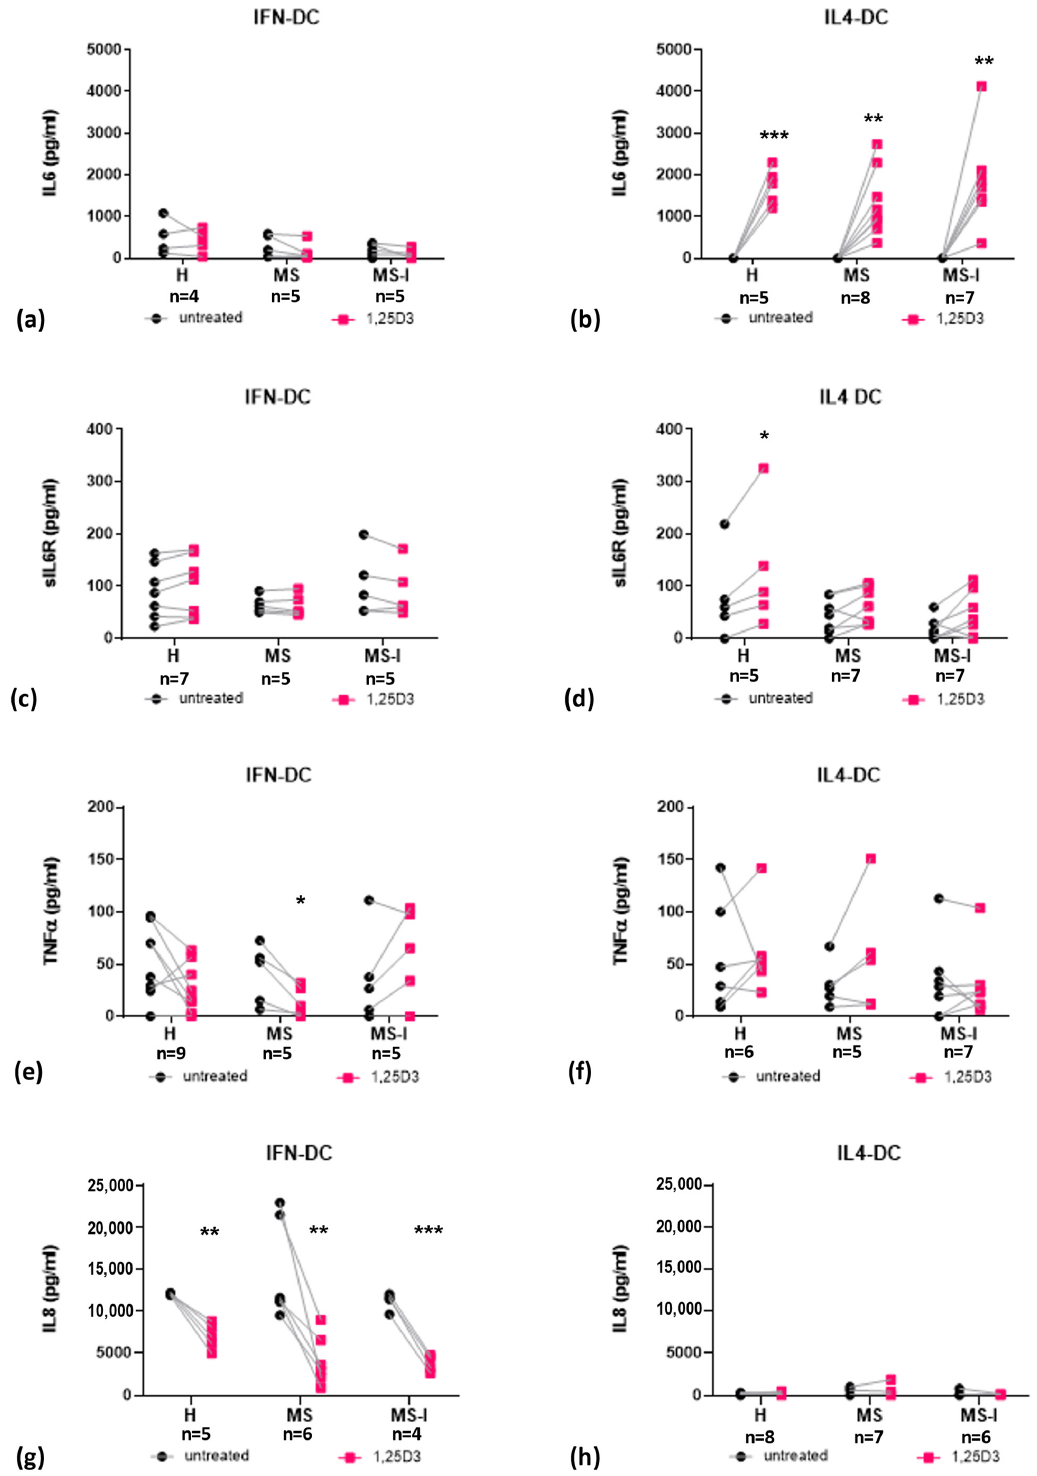
Figure 3. Expression and modulation by 1,25(OH) 2 D3 of pro-inflammatory cytokines. IL6 ( a , b ), sIL6R ( c , d ), TNF α ( e , f ) and IL8 ( g , h ) concentrations measured in IFN-DC ( a , c , e , g ) and IL4-DC ( b , d , f , h ) supernatants from H, MS, and MS-I donors are shown as individual values. Number of subjects (n) analyzed are indicated. Black dots represent untreated cells, pink squares represent 1,25(OH) 2 D3 treated cells. 1,25(OH) 2 D3 treatment effects were tested by Student’s t -test for paired samples. * p ≤ 0.05, ** p ≤ 0.01, *** p ≤ 0.001. No donor effect was found by two-way ANOVA with Tukey’s